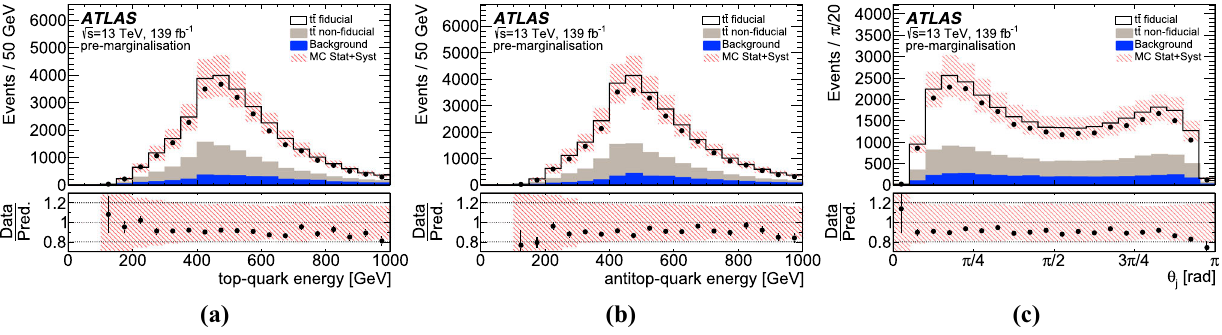
blue area. The shaded red bands correspond to the total uncertainty of the prediction, while the statistical uncertainty on the data is indicated ¯ t by the black error bars, that are mostly smaller than the size of the marker